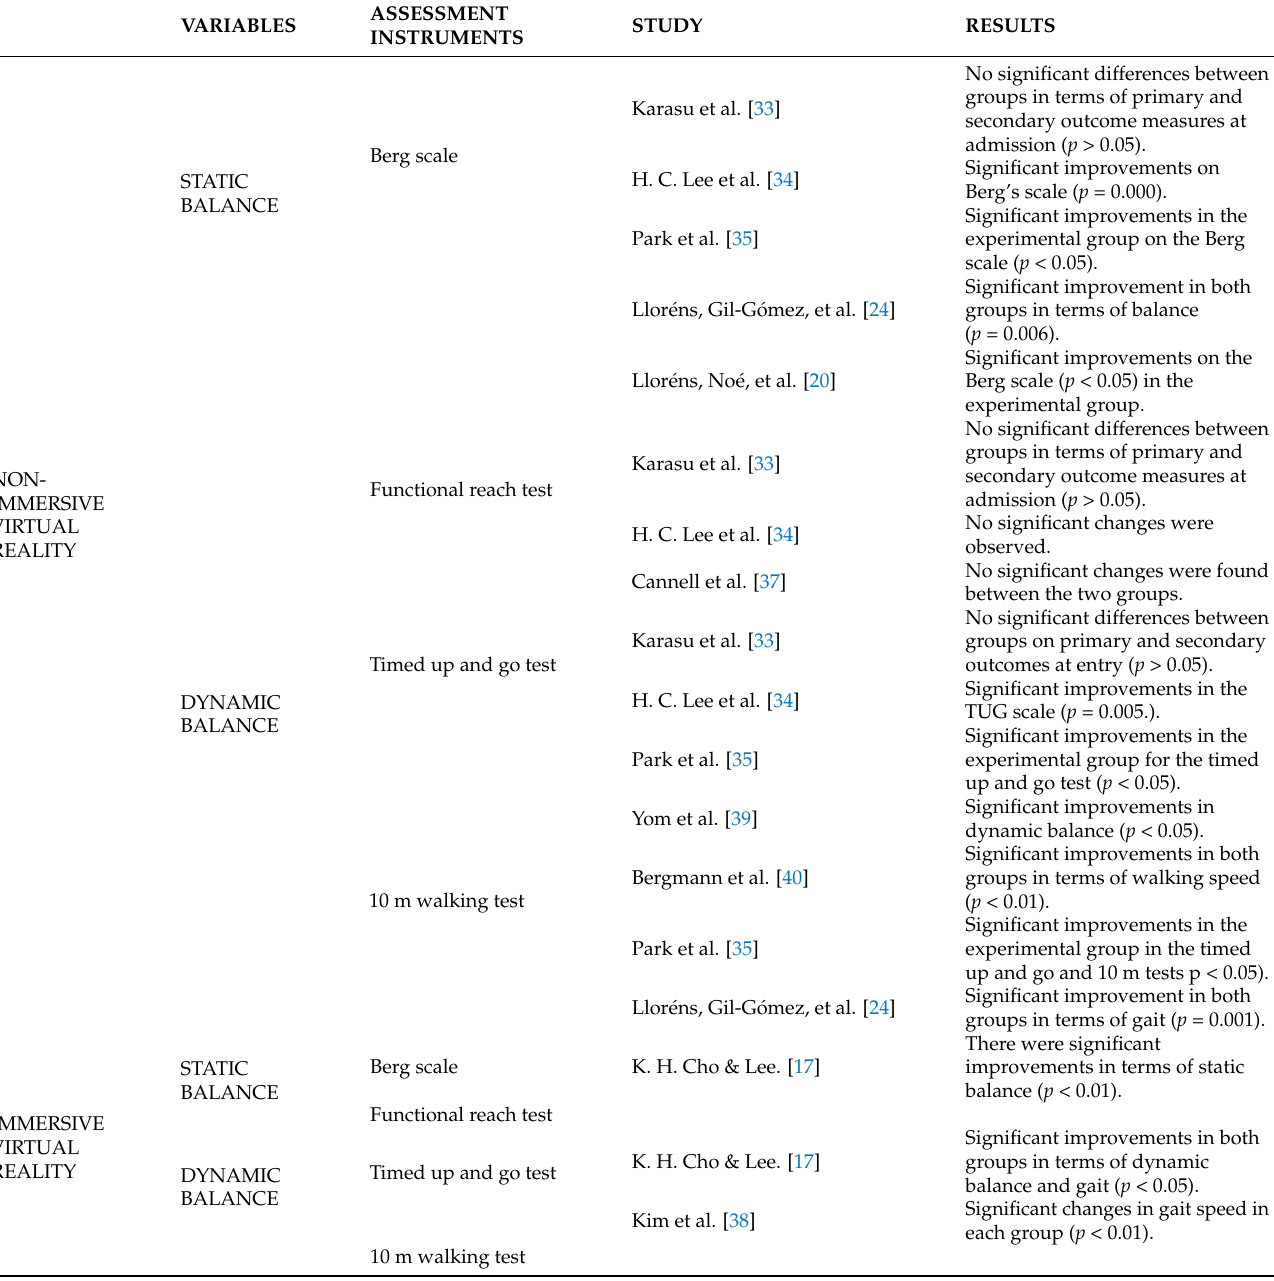
Table 4. Grouping of studies according to the type of virtual reality and the balance